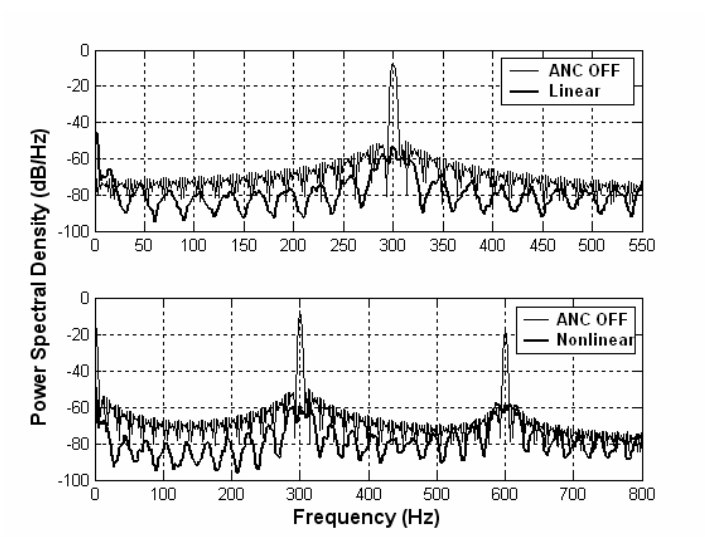
Fig. 9. The error signal spectrum for case